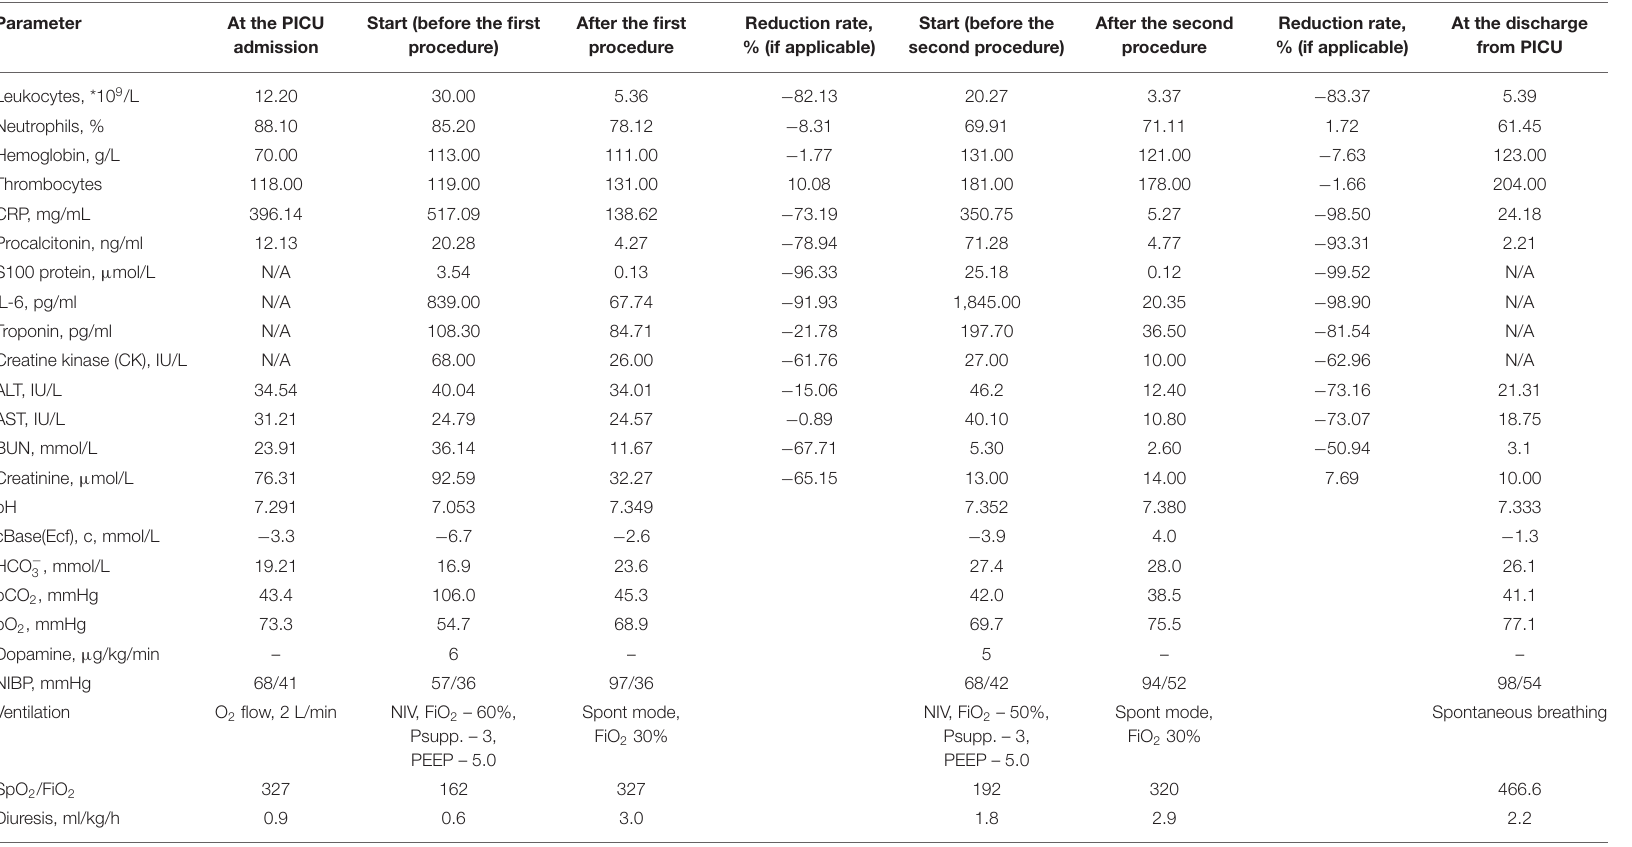
CRP, C reactive protein; IL-6, Interleukin 6; ALT, Alanine Aminotransferase; AST, Aspartate Aminotransferase; BUN, Blood Urea Nitrogen; NIBP, Non-Invasive Blood Pressure; NIV, Non-Invasive Ventilation; FiO 2 , fraction of inspired oxygen; Psupp, pressure support; PEEP, Positive End-Expiratory Pressure; Spont mode, Spontaneous Mode of Mechanical Ventilation; HCO 2 , Bicarbonate; pCO 2 , Partial Pressure of Carbon Dioxide; pO 2 , Partial Pressure of Oxygen; SpO 2 /FiO 2 , Oxygen Saturation to Fraction of Inspired Oxygen Ratio; cBase(Ecf), Base Excess in Extracellular Fluid; HPAP, Hooded/Helmet Positive Airway Pressure; APVSIMV, Synchronized Intermittent Mandatory Ventilation with Adaptive Pressure Ventilation; SIMV, Synchronized Intermittent Mandatory